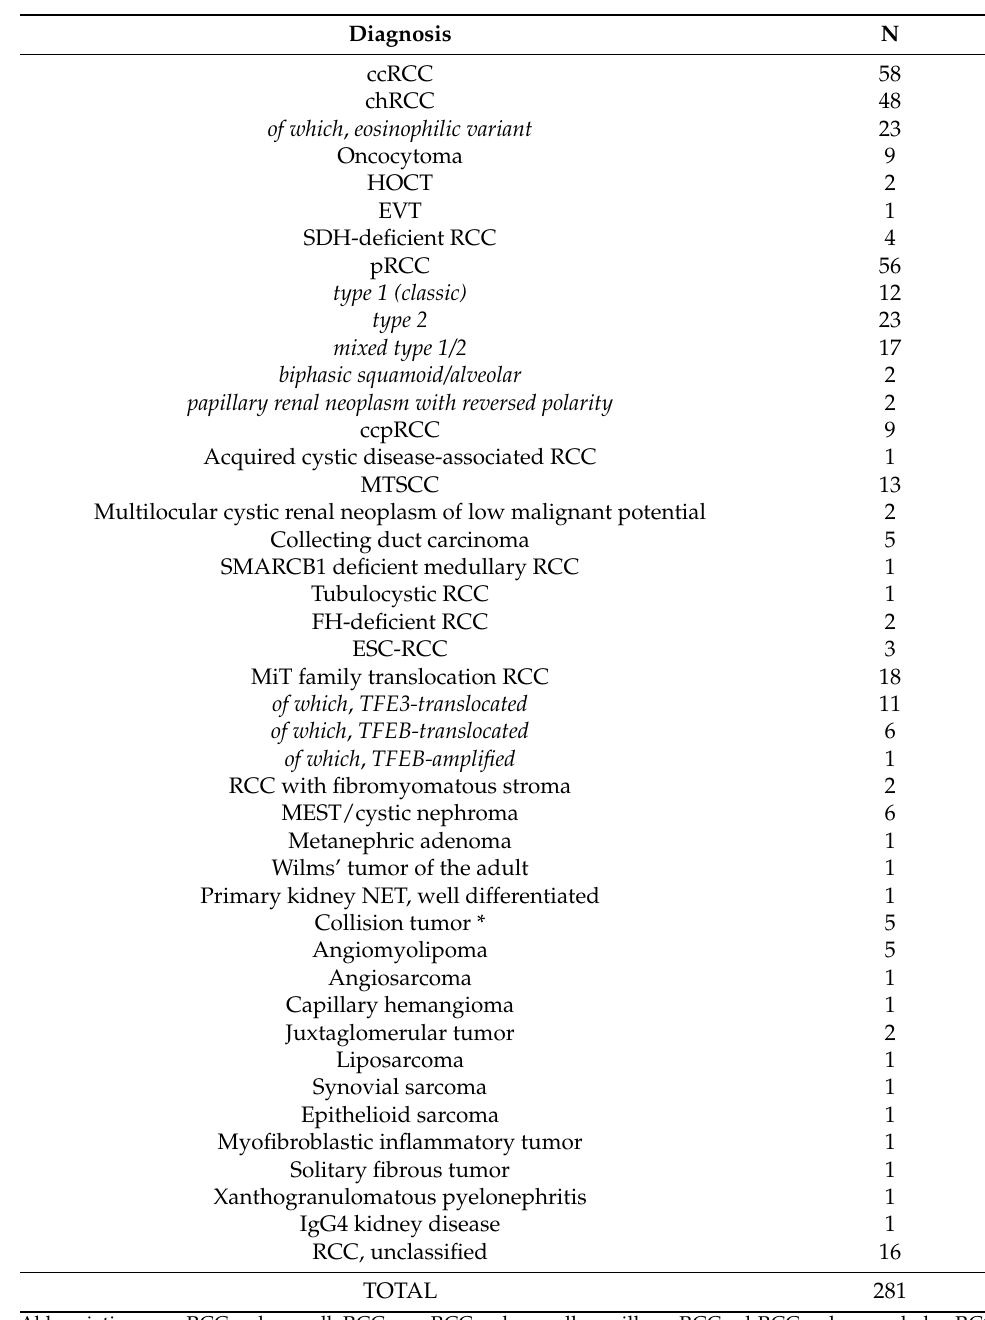
Table 3. Prevalence of renal tumor subtypes in a consultation cohort (cohort